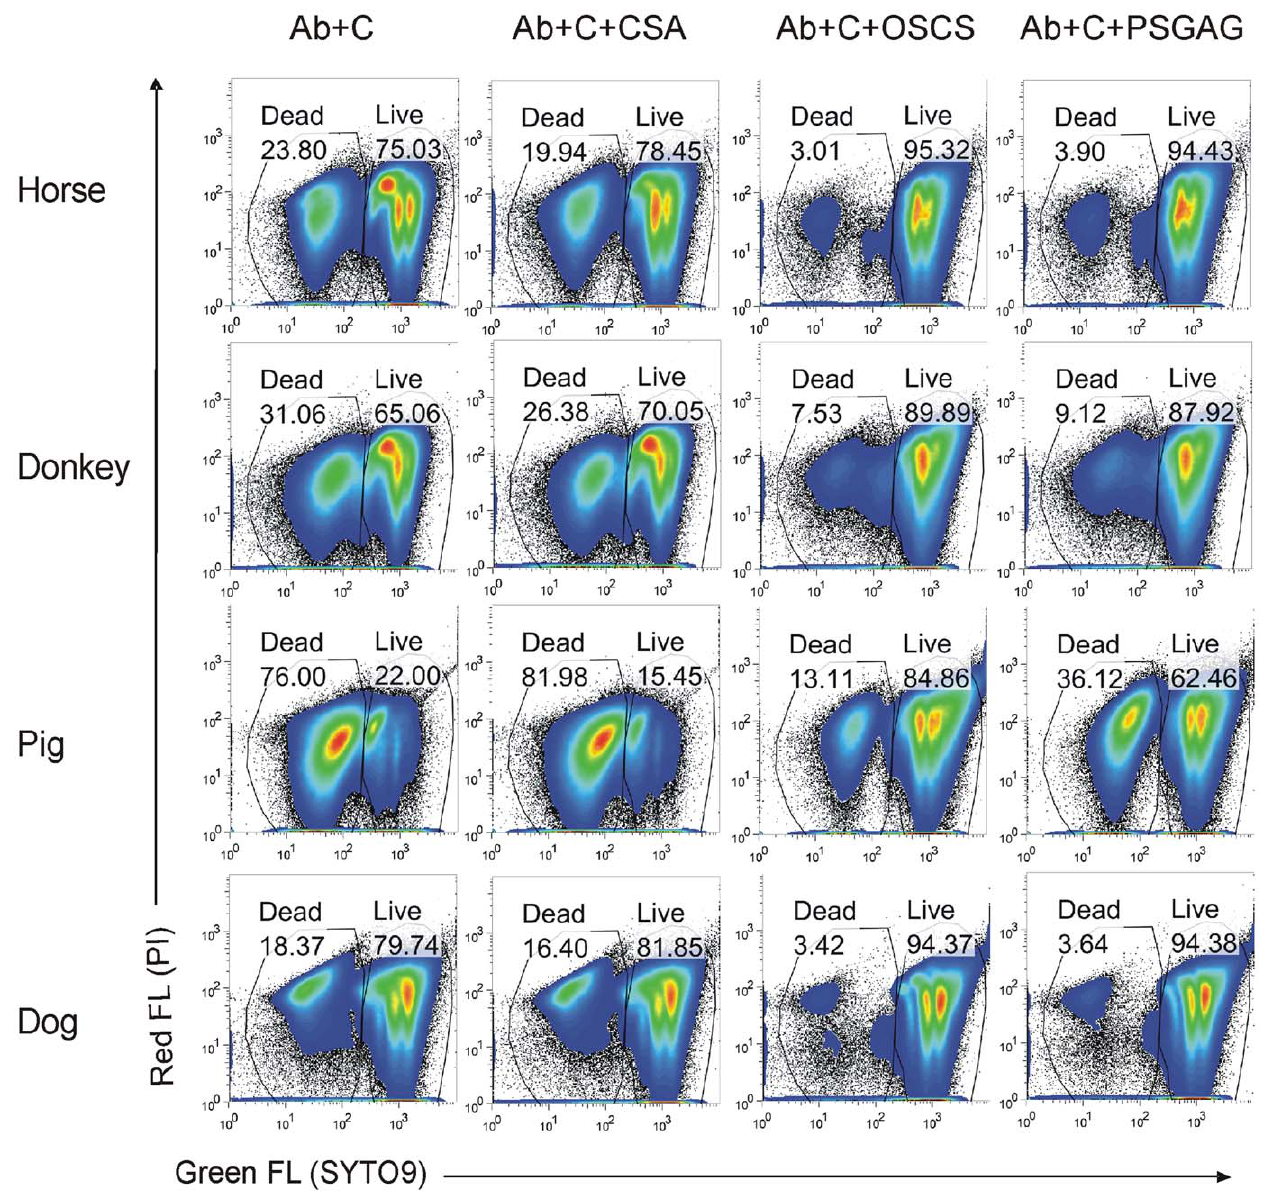
Figure 7. Polysulfated glycosaminoglycan (PSGAG) inhibits complement activity in animals. 2E4 antibody-treated E. coli BL21 bacteria were incubated with complement from pooled horse, donkey, pig or dog plasma, or incubated with the same pooled plasma pre-treated with 20 m g/ ml of CSA, OSCS or PSGAG. Bacterial viability was determined by an SYTO9/PI staining bacterial viability kit and flow cytometry. Dead and live bacterial populations and percentages are indicated. Data shown are representative of three independent